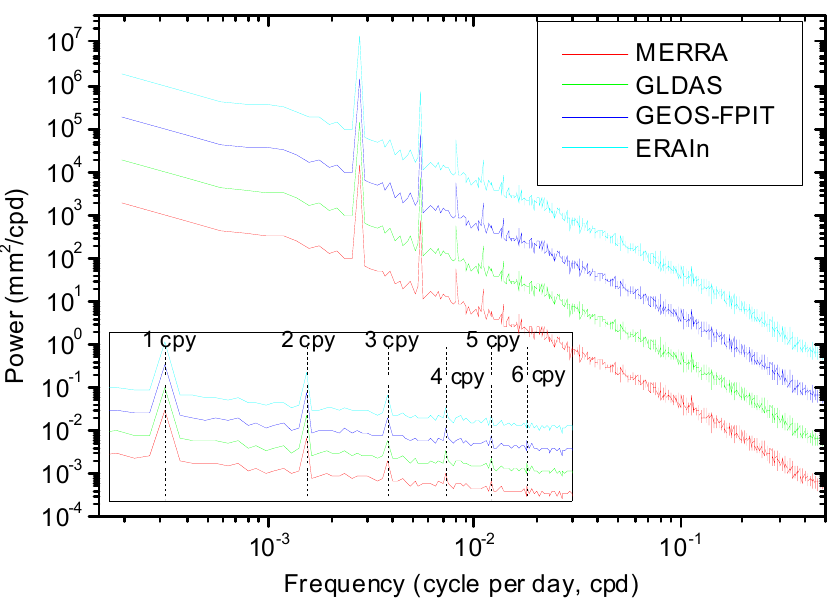
Figure 2. Stacked periodogram of hydrology predictions for the 70 GPS sites considered. Vertical dashed lines in the zoom part indicate harmonics of about 1.0 cycle per year (cpy).